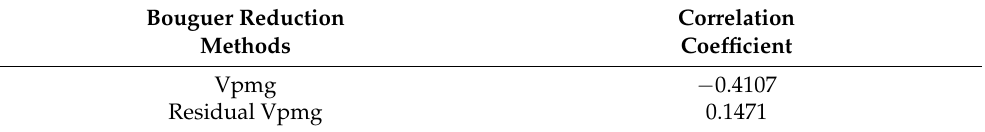
Table 1. Correlation